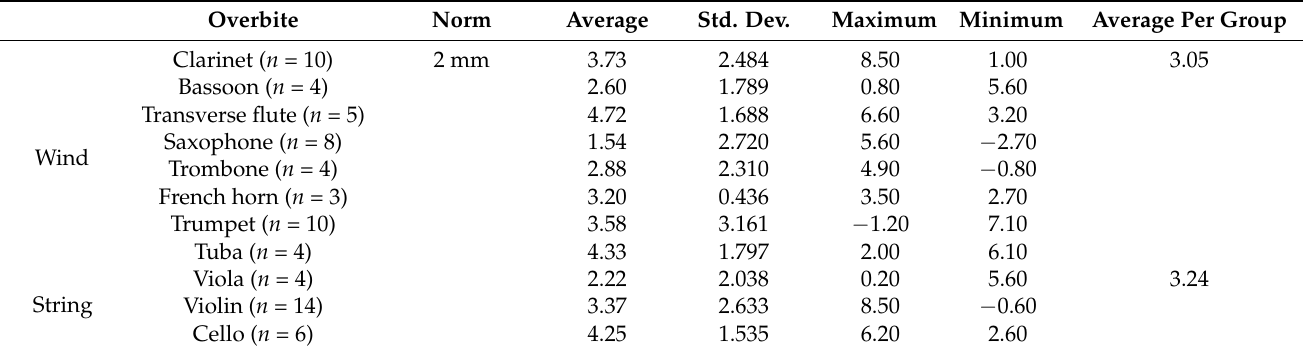
Table 3. Descriptive statistics for the variable overbite.